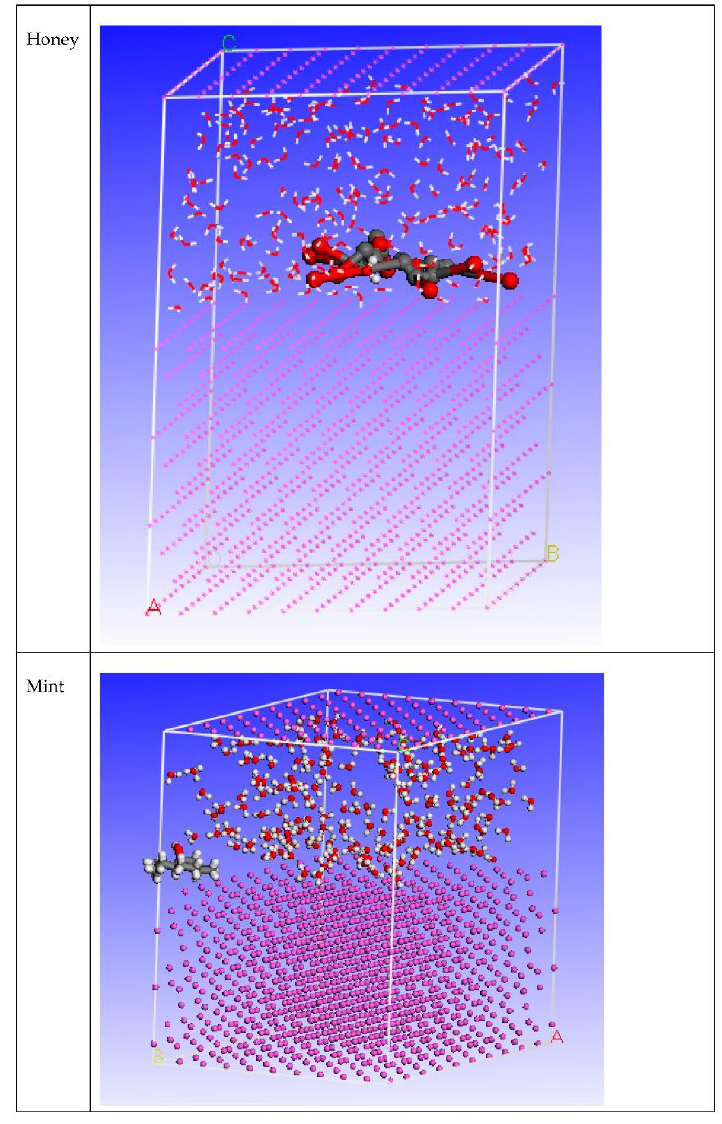
Figure 4. The adsorption locator module achieved the maximal suitable conformation for the adsorp- tion of the synthesized hydrazides on the Al (1 1 1) substrate. Table 3. Data and descriptors obtained using the Monte Carlo simulation for the adsorption of Honey and Mint compounds on Al (1 1 1) a